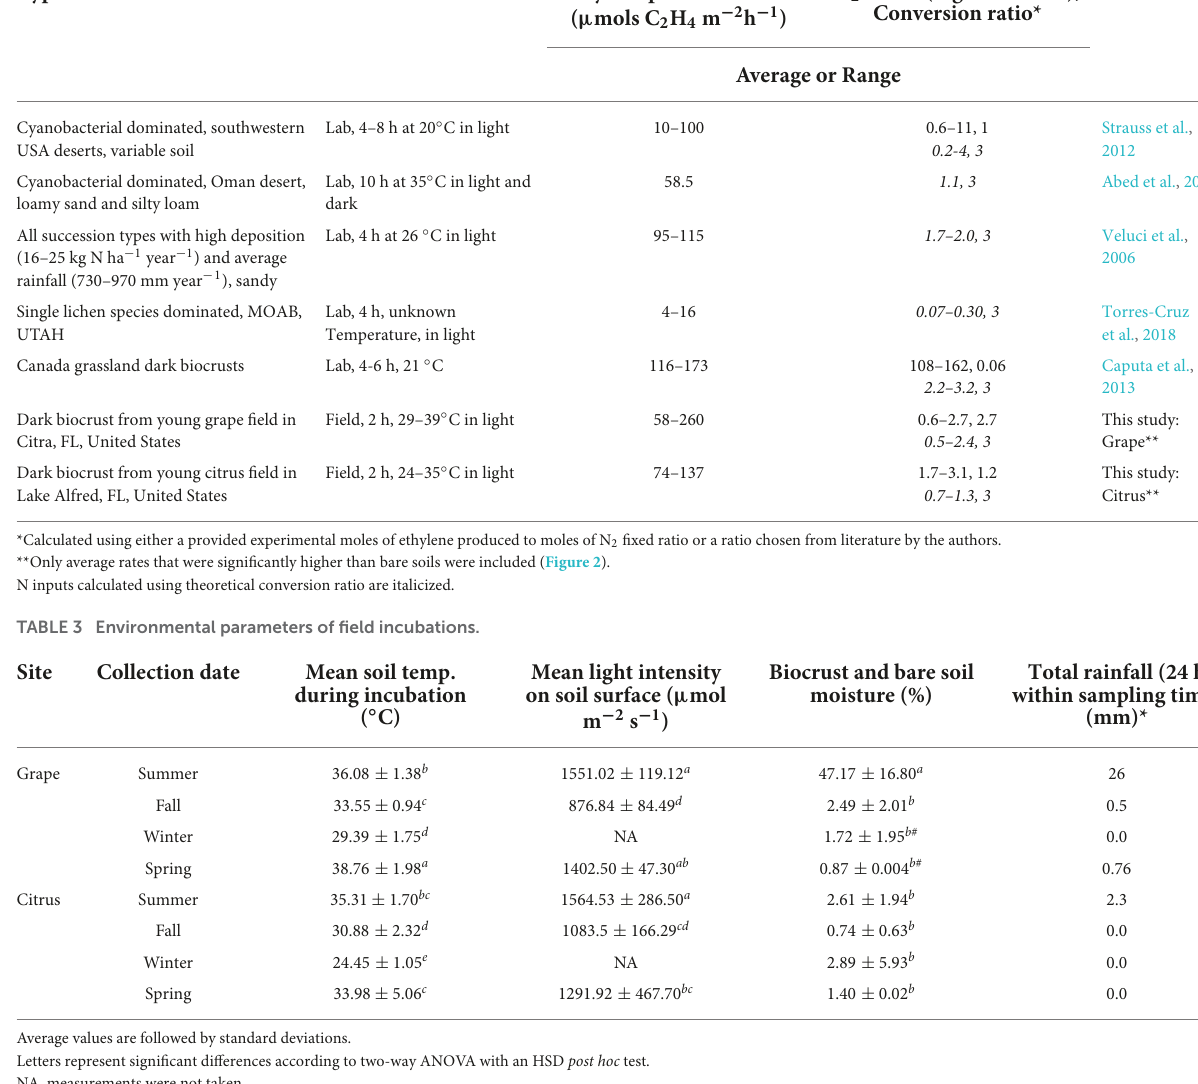
TABLE 2 N 2 -fixation rate comparison of this study’s rates to literature rates.